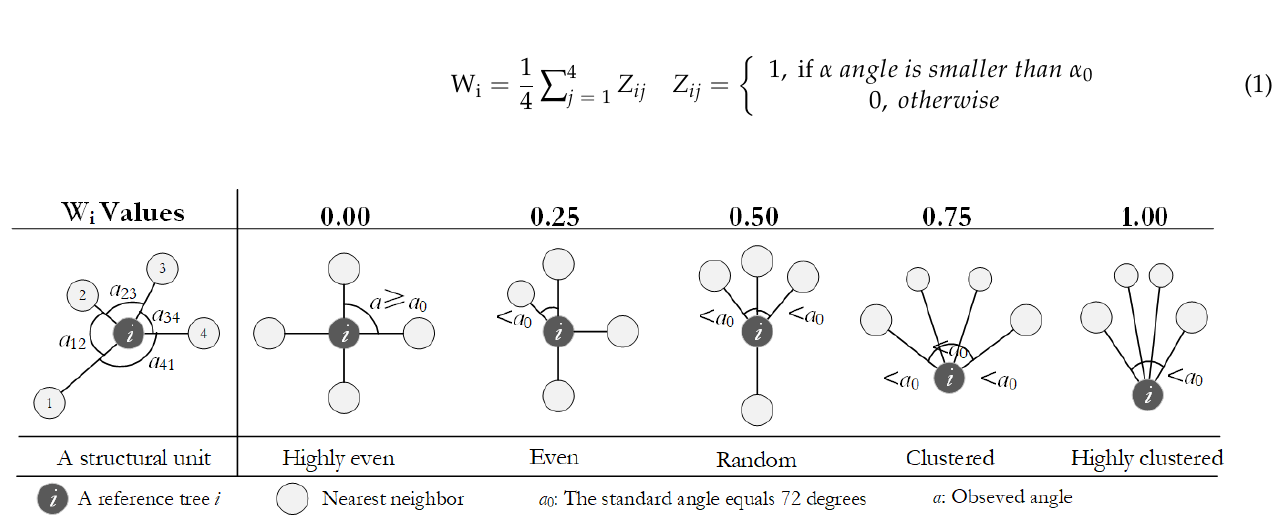
Figure 2. A structural unit and the principle of the uniform angle index.